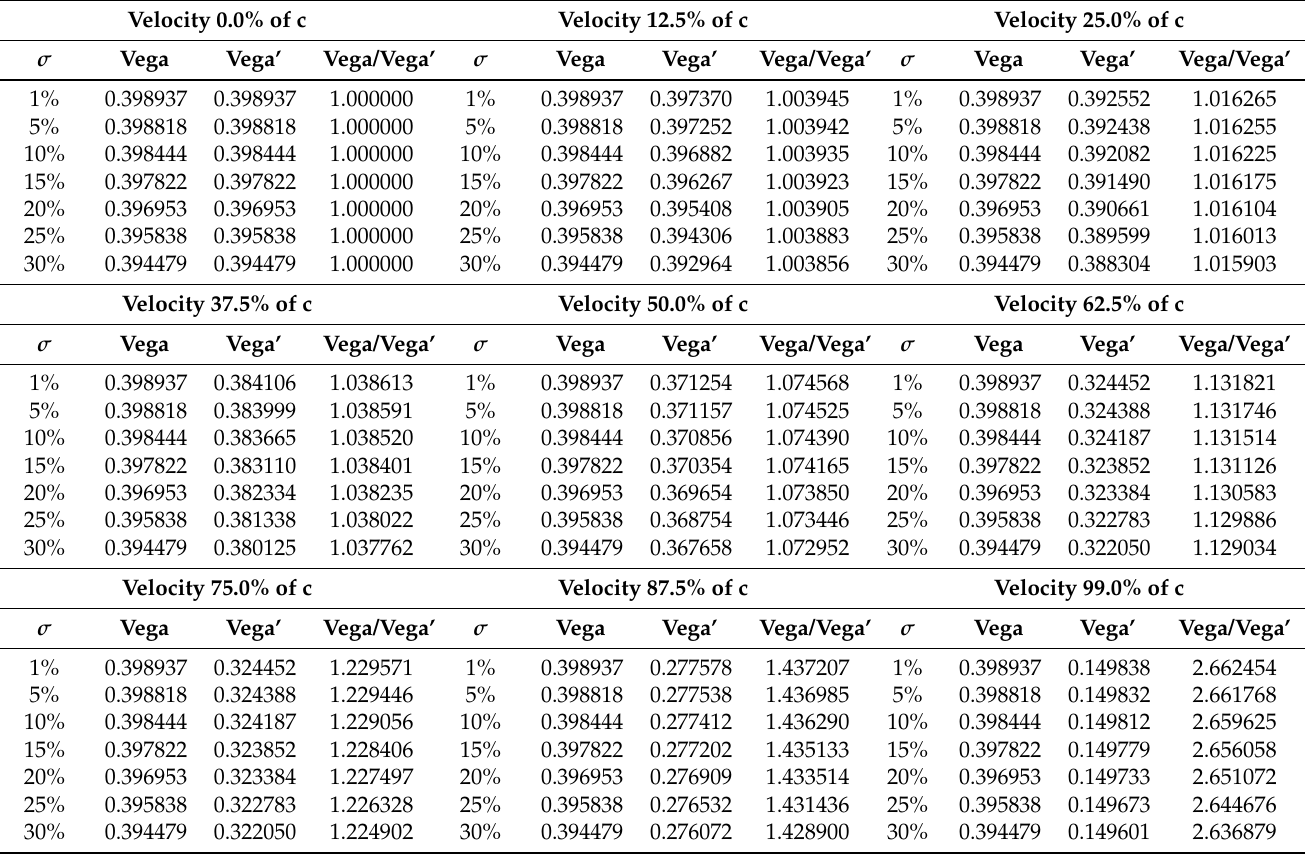
Table 4. Values for Vega , Vega (cid:48) and the ratio Vega / Vega (cid:48) (for a Call or Put), per calendar day, for the volatilities 1.0%, 5.0%, 10.0%, 15.0%, 20.0%, 25.0% and 30.0%, for maturity T = 1 year and for the velocities 0.0%, 12.5%, 25.0%, 37.5%, 50.0%, 62.5%, 75.0%, 87.5% and 99.0% of c . For simplicity, we consider the values at inception t = 0 and r = 0% and both asset prices at inception and strike equal to one S = K = 1. Vega (cid:48) is vega for a reference frame that is moving and measures less time for velocities >